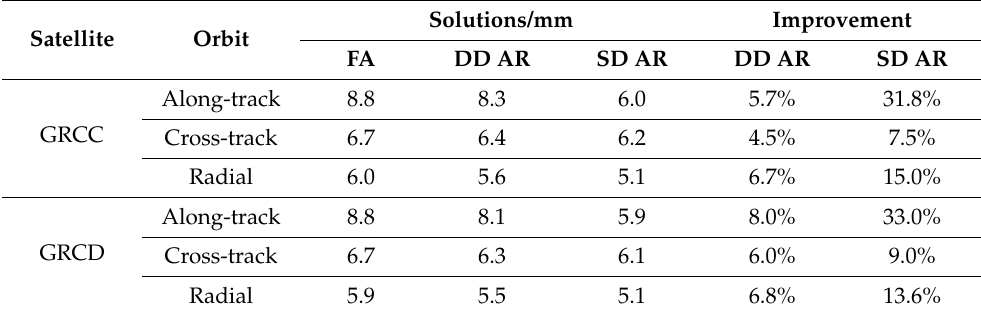
Figure 8. Daily RMSs of along-track orbit differences of FA, DD AR, and SD AR solutions with JPL’s orbit. The upper panel is for the GRCC satellite and the lower panel is for the GRCD satellite. Table 4. RMSs of differences between the FA, DD AR and SD AR orbits and JPL’s